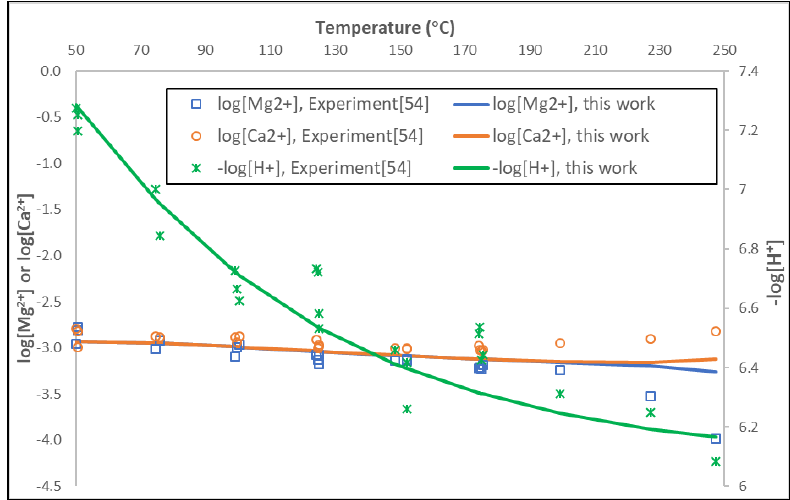
Figure 9. Aqueous species concentration in equilibrium with dolomite obtained from experimental results [54] and the calculated results by this model at various temperatures.